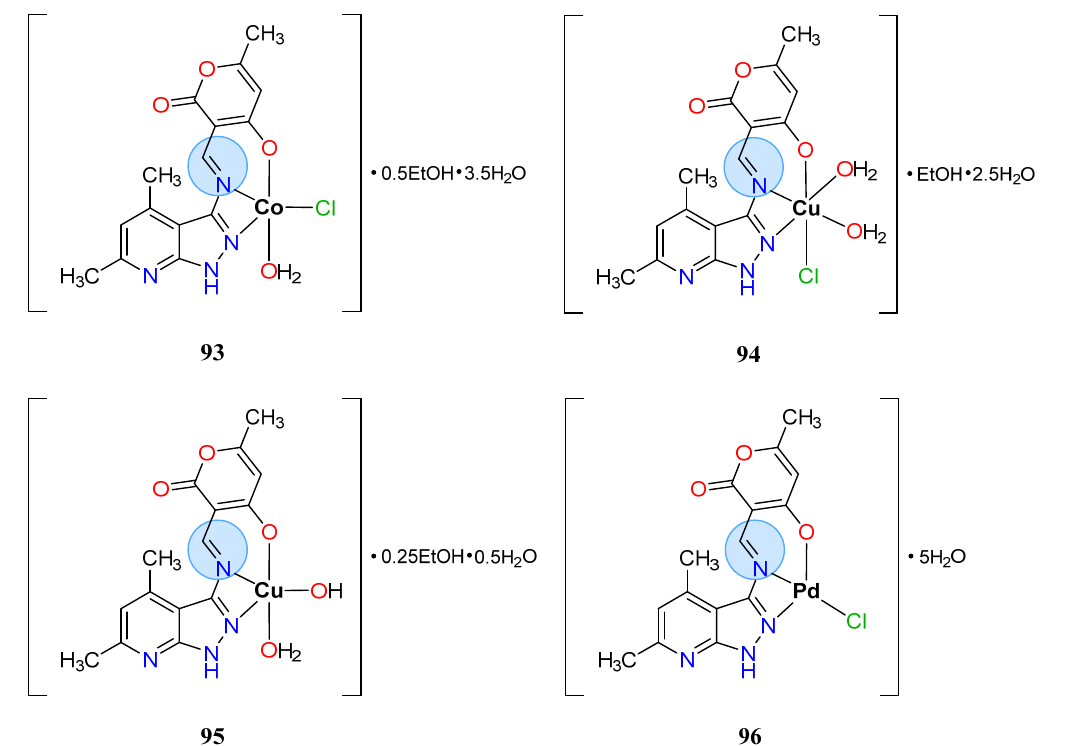
Figure 50. Metal complexes containing Schiff base ligand named (Z) ‐ 3 ‐ (1 ‐ ((4,6 ‐ dimethyl ‐ 1 H ‐ pyra ‐ zolo [3,4 ‐ b] pyridin ‐ 3 ‐ yl)imino)ethyl) ‐ 4 ‐ hydroxy ‐ 6 ‐ methyl ‐ 2 H ‐ pyran ‐ 2 ‐ one. [3,4-b] pyridin-3-yl)imino)ethyl)-4-hydroxy-6-methyl-2 H